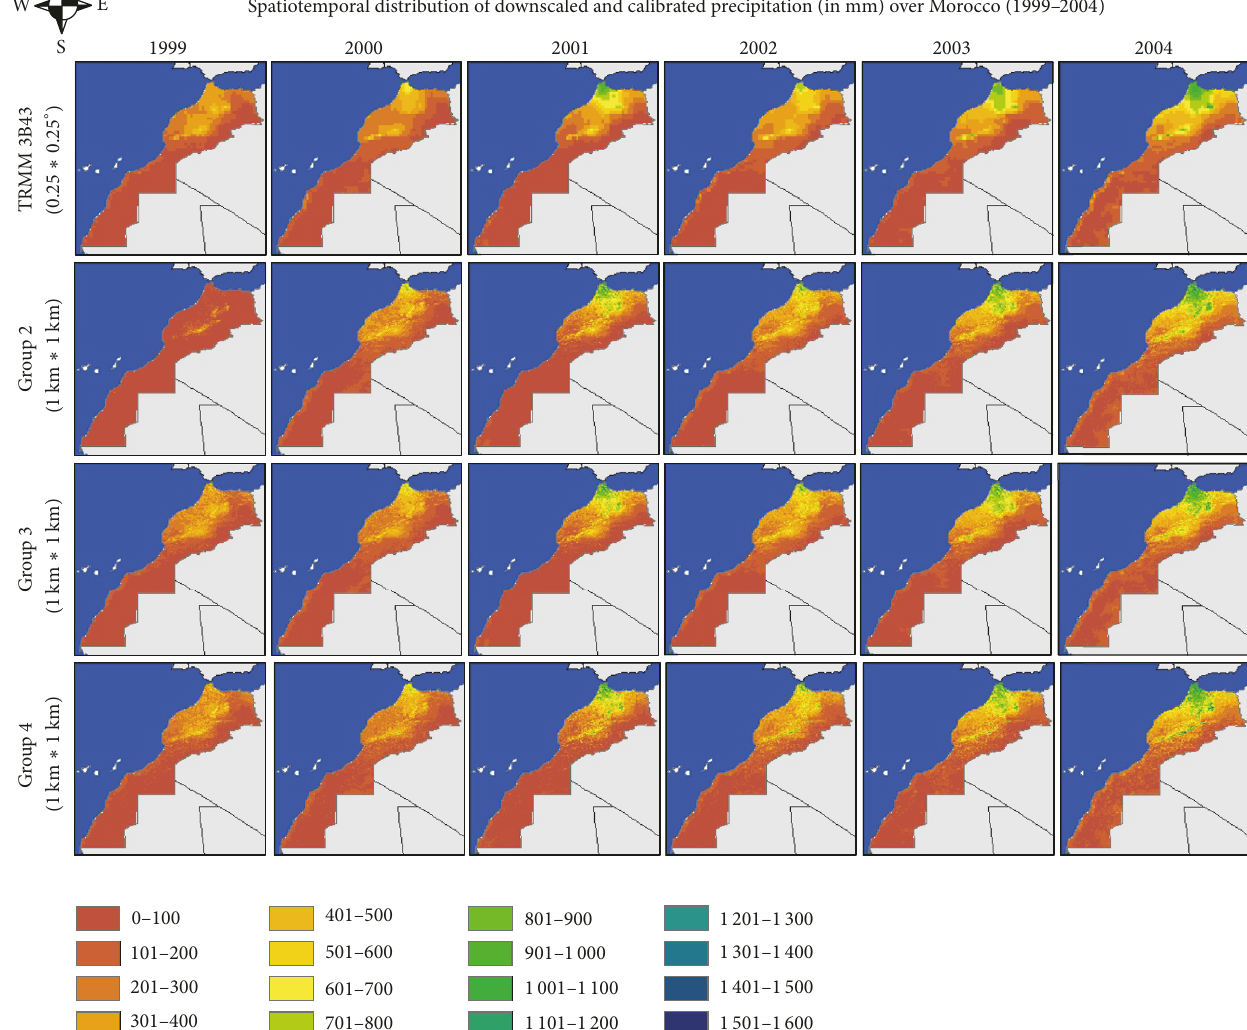
Figure 7: Spatial distribution of downscaled and calibrated precipitation over Morocco based on TRMM 3B43 product, according to Groups 2, 3, and